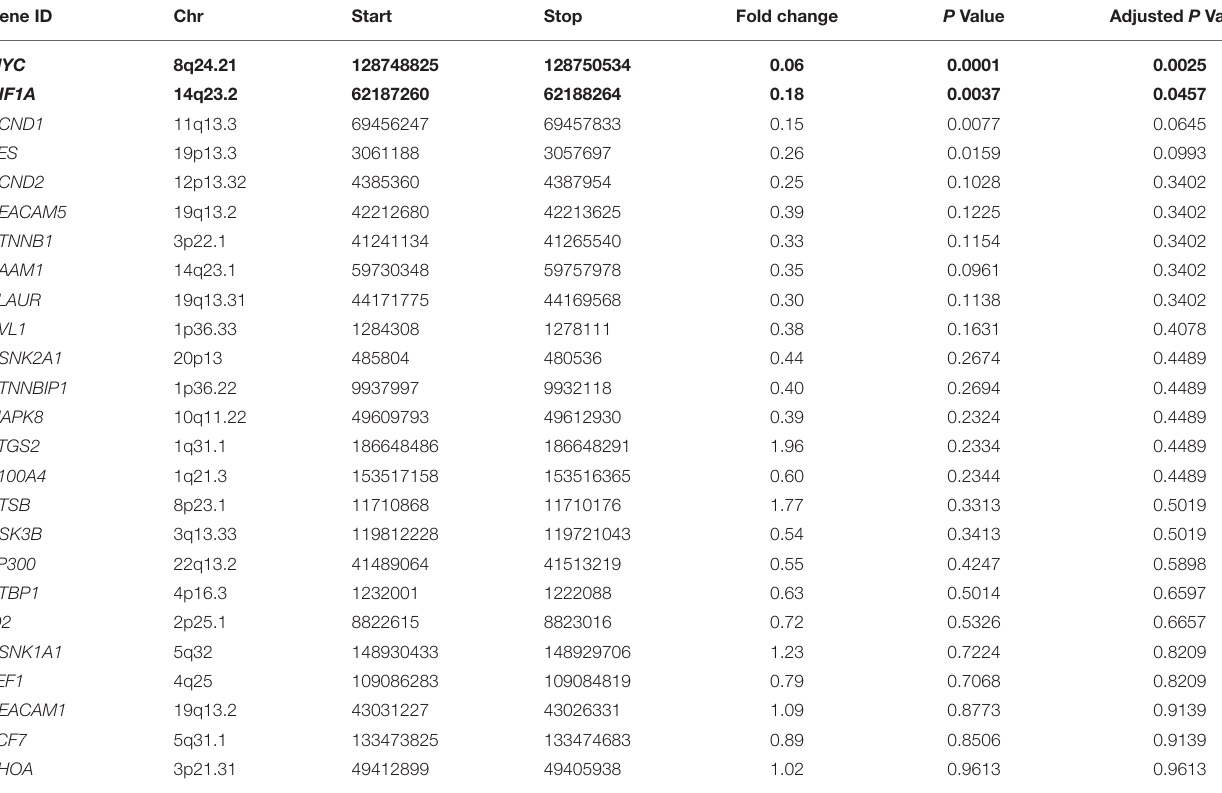
TABLE 3 | The differential gene expression in two centrifugal forces analyzed by DESeq2 (3,500 vs. 1,600g followed by